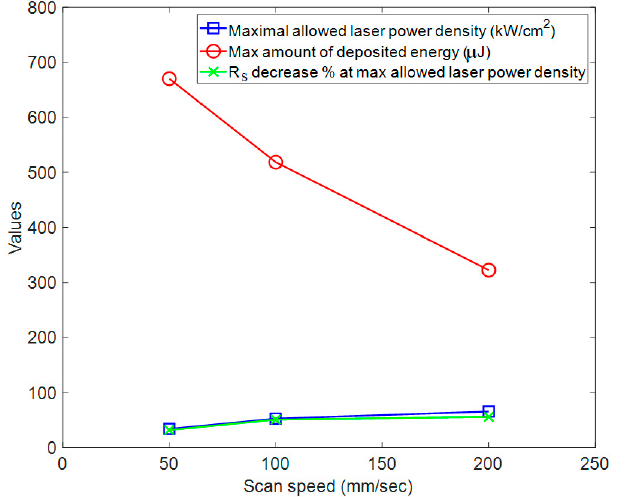
Figure 5. Effect of scan speed on the laser nanowelding process. As the scan speed increased, max- imum allowed laser power density (blue) increased. The total amount of energy (red) decreased as the dwell time at higher scan speed was shorter. The percentage decrease of R s (green) was more strongly correlated with laser power density rather than the total amount of energy. All data are based on a single time